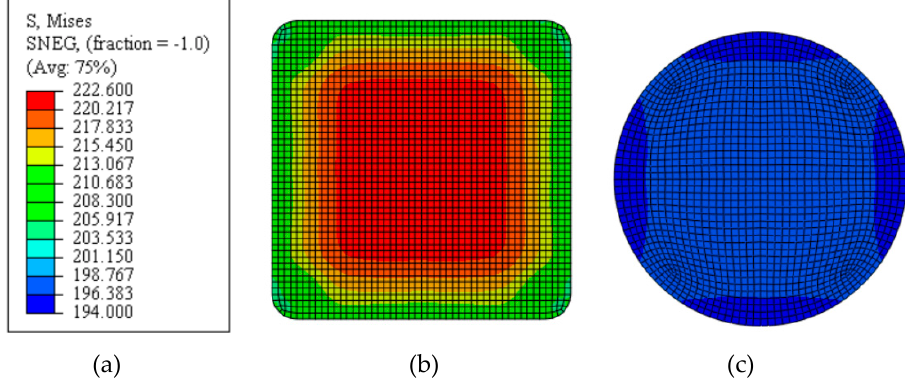
Figure 12. Stress contour diagram of central region with two type specimens. ( a ) stress contour bar; ( b ) original specimen; and, ( c ) optimum specimen.